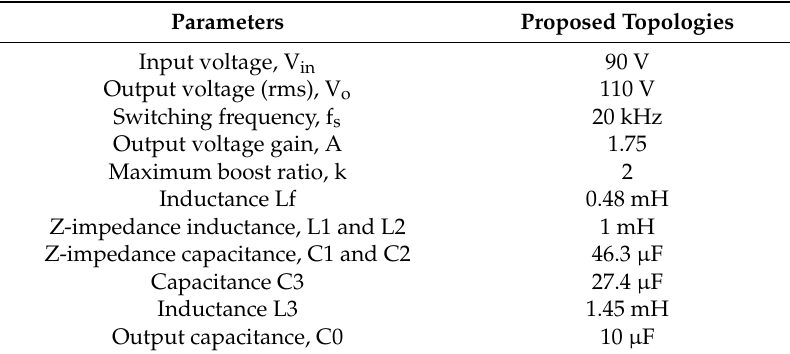
Table 1. Simulation parameters for current topology.